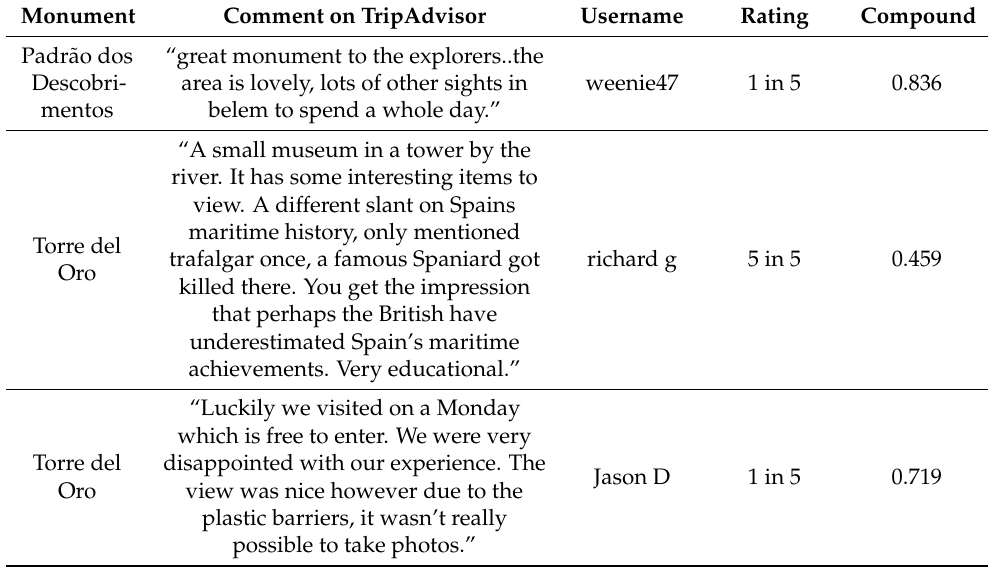
Table 5. Quotations whose ratings are not linked to the compound value obtained by VADER